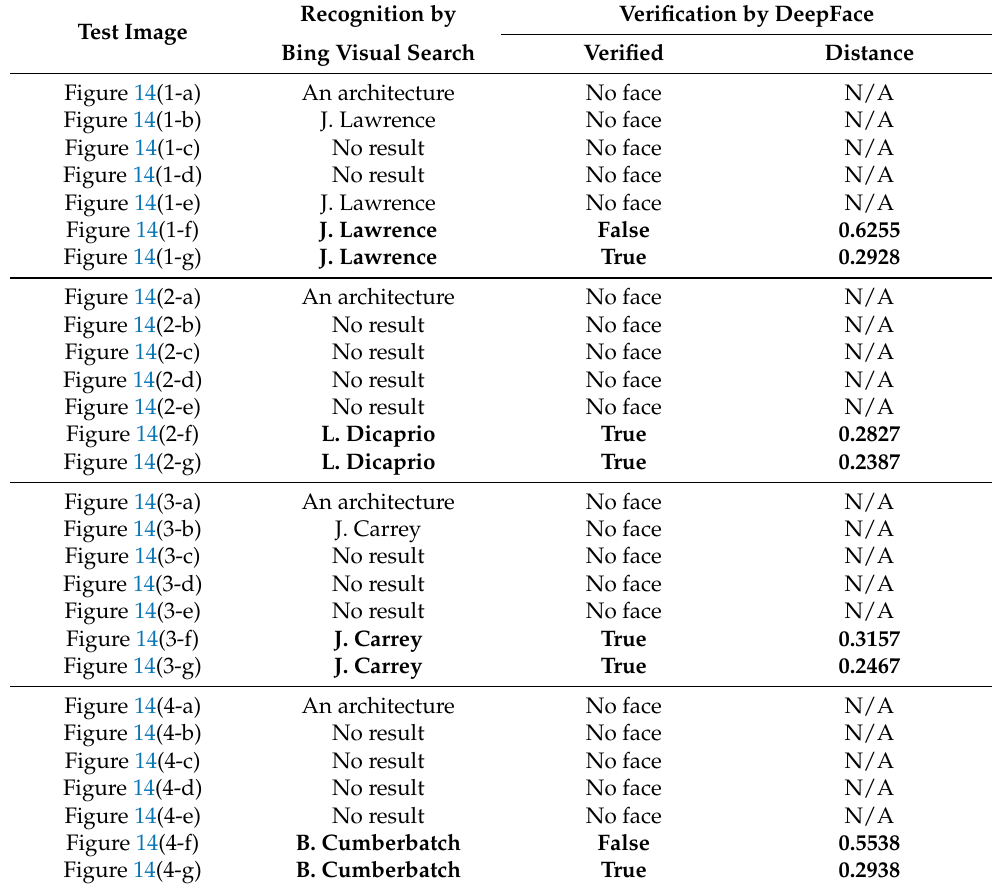
Table 6. Face identification results on two mainstream platforms. (Our results are highlighted in